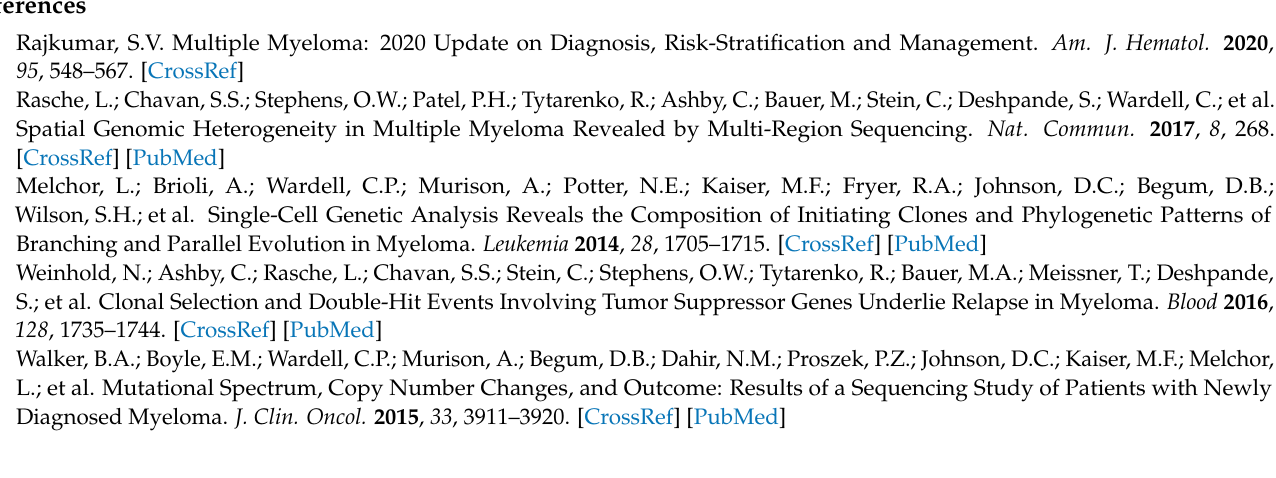
Figure S2: Prognostic significance of clinical risk factors in the study cohort; Table S1: Gene panel; Table S2: Summary of identified gene variants; Table S3: Summary of the genetic profile of each subsequent